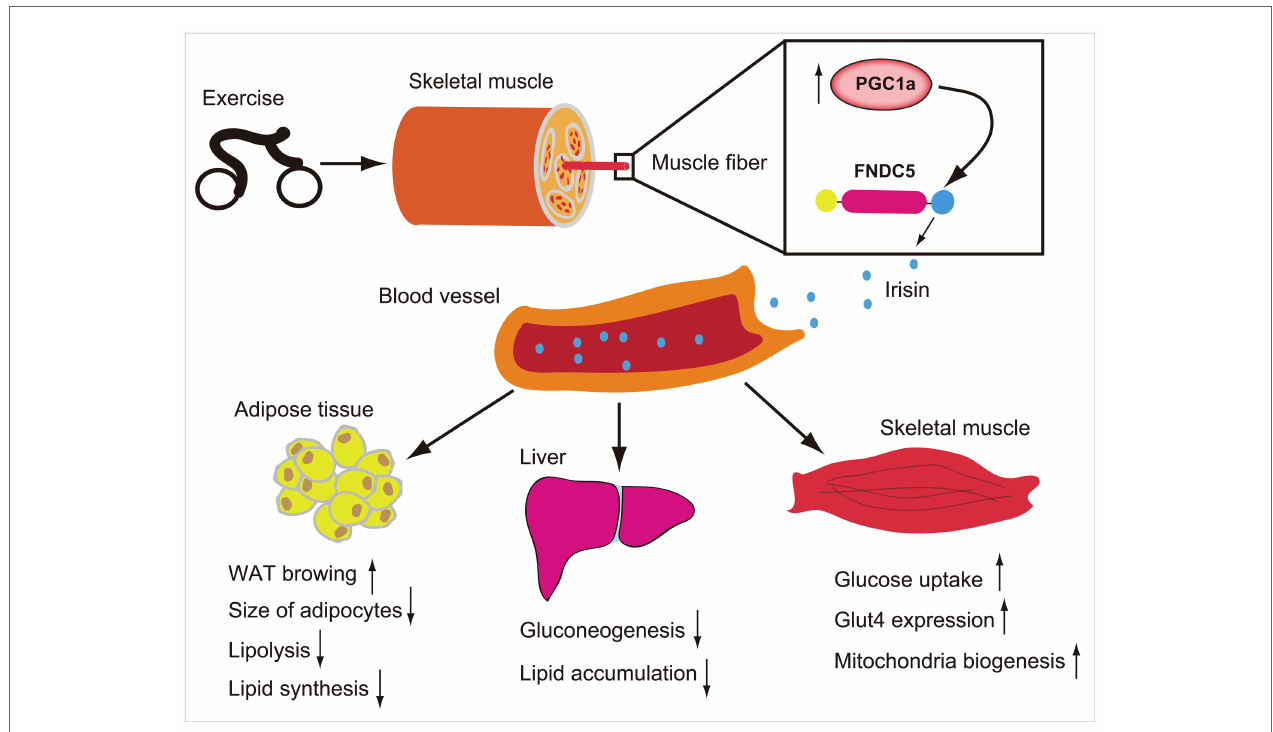
FIGURE 1 | Exercise induces increase of PCG1a expression in skeletal muscle, which in turn drives the production of membrane protein fibronectin type III domain- containing protein 5 (FNDC5). The FNDC5 is cleaved and secretes irisin (blue ball). Irisin enters in the blood circulation and participates in the metabolic regulation of lipid and glucose in some organs such as skeletal muscle, liver, and adipose